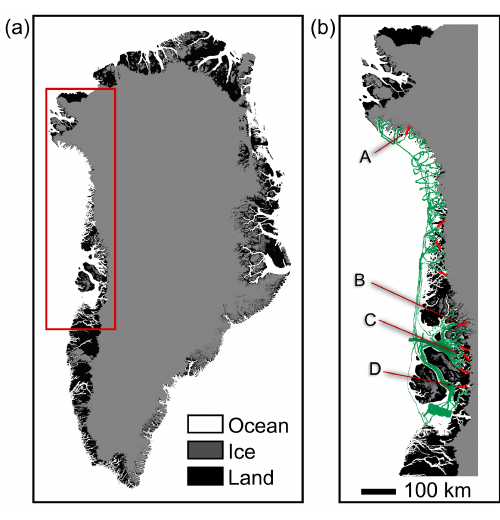
Figure 7. (a) Area of interest considered for selection of fjord cen- trelines for spectral analysis relative to the GIMP land classification mask (Morlighem et al., 2014). (b) Fjord centrelines (red) selected along the west coast of Greenland, with the bathymetric observa- tional DEM also displayed (green) (Rignot et al., 2016, OMG Mis- sion, 2016) – centrelines were only selected where data were avail- able, with gaps affecting < 20% of the overall profile length. Labels on (b) relate to the profiles illustrated in Fig.